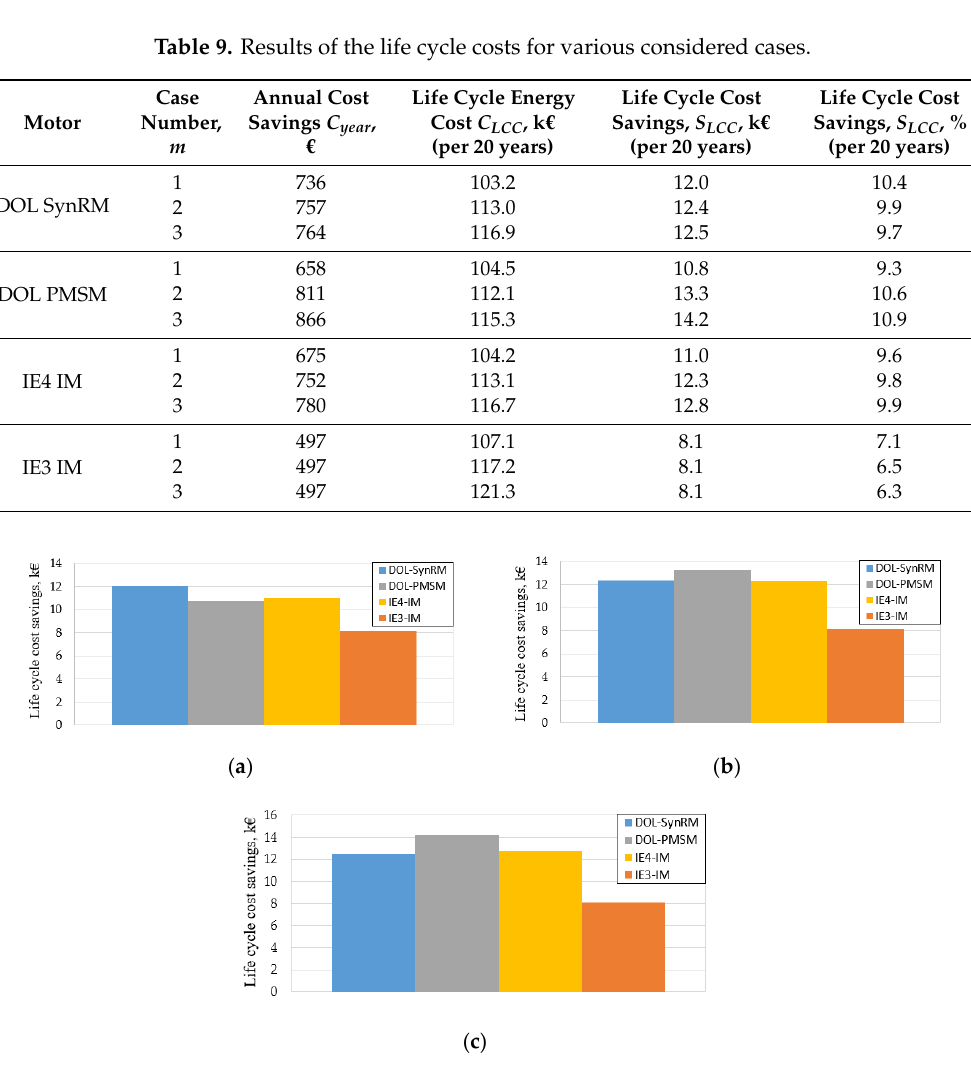
Figure 9. Life cycle cost savings (20 years) using various motor types: ( a ) case 1 (without cable and transformer losses); ( b ) case 2 (3 pump units, considering the cable loss); ( c ) case 3 (3 pump units, considering the cable and transformer losses).